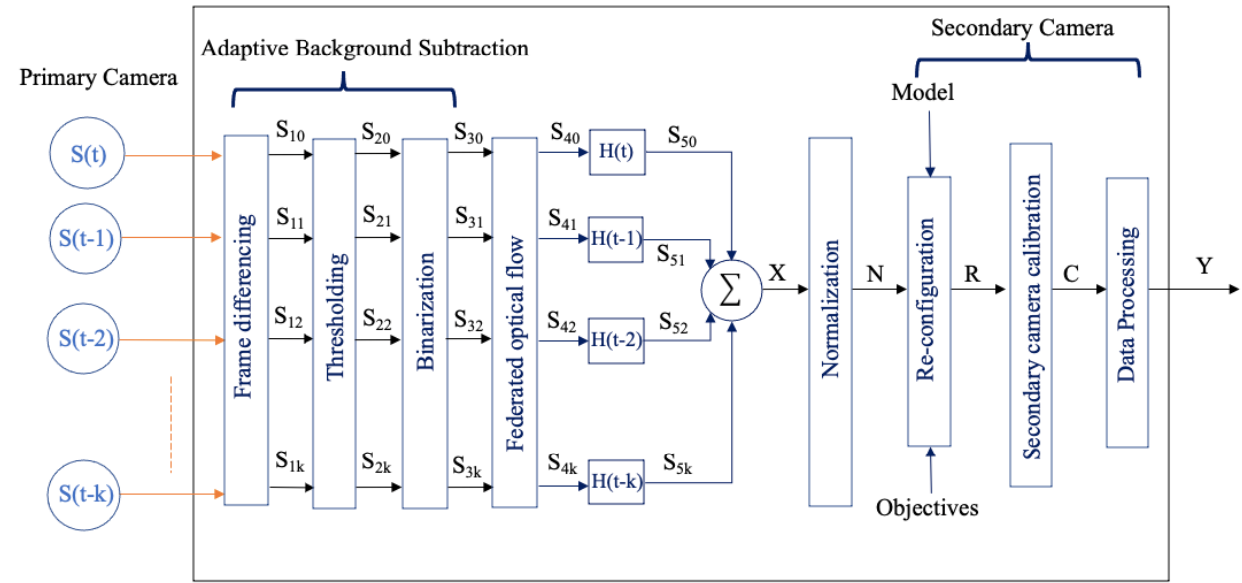
Figure 1. Adaptive spatiotemporal activity mapping framework.